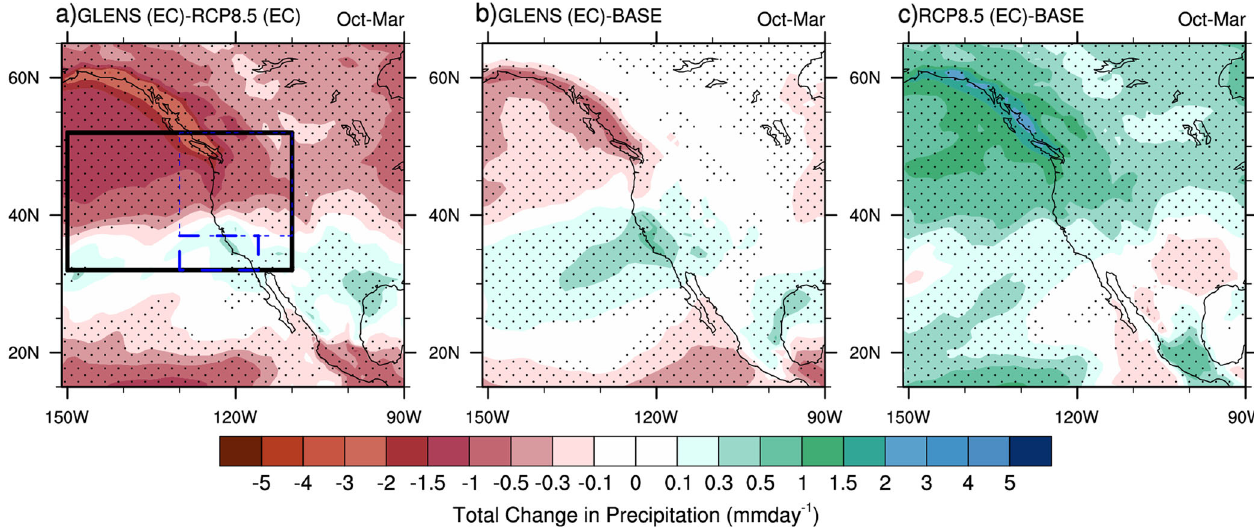
Fig. 4 Cool season total precipitation for analysis scenarios. Total precipitation change for cool season means (Oct – Mar). GLENS (EC) - RCP8.5 (EC) ( a ), GLENS (EC) - BASE ( b ), RCP8.5 (EC) - BASE ( c ). Precipitation units are mm day 1 . Stippling is computed at 95% signi fi cance with a Student ’ s T test. The black box in a signi fi es the AR-dynamics analysis region (Figs. 2 and 3) with the blue boxes signifying AR-precipitation impacts regions (Figs. 5 and